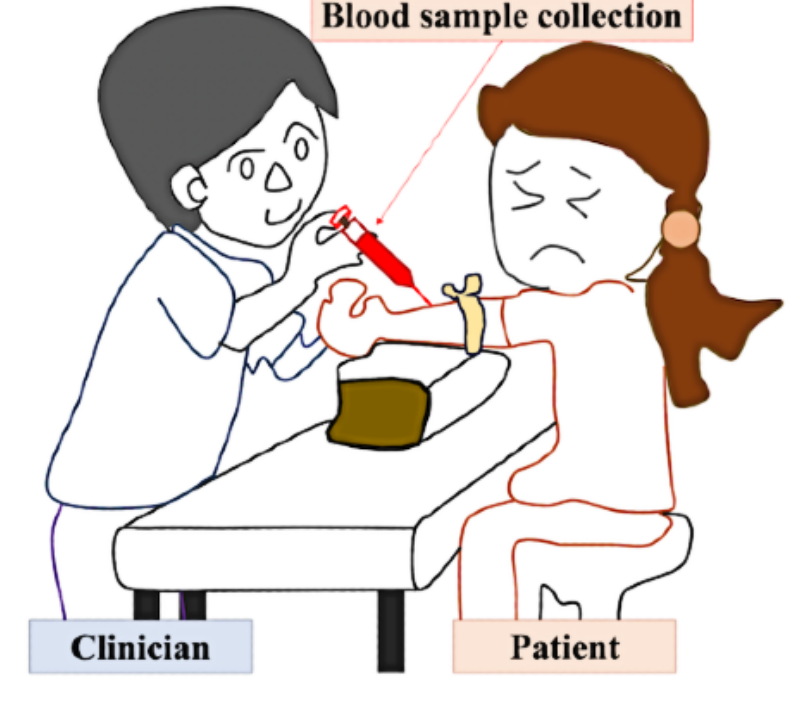
Figure 2. Collecting patient's blood sample for doing invasive hemoglobin